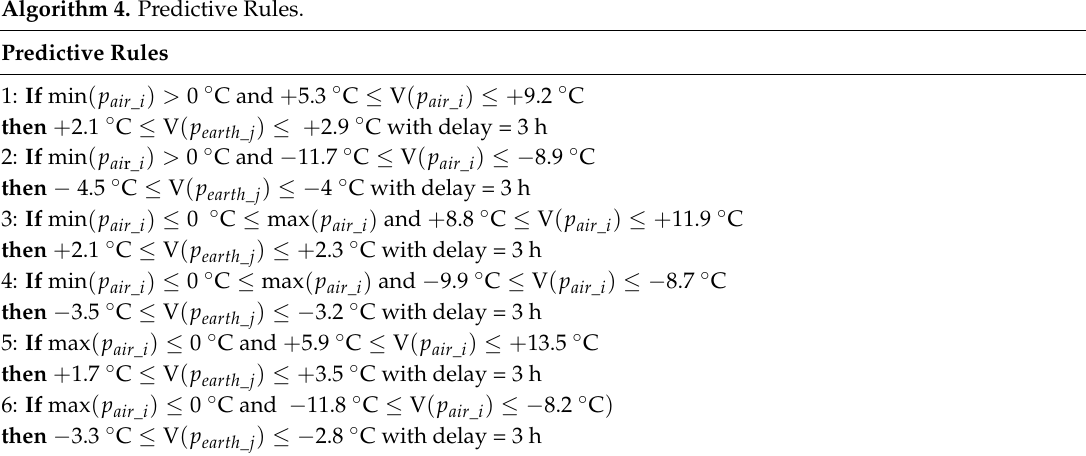
Algorithm 4. Predictive Rules.